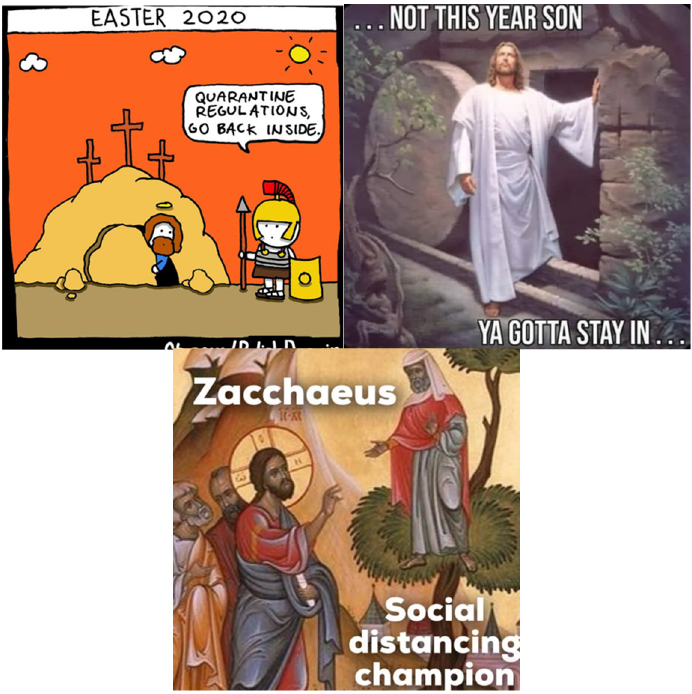
Figure 4. Examples of memes that depict Jesus as supportive of social distancing behaviors.